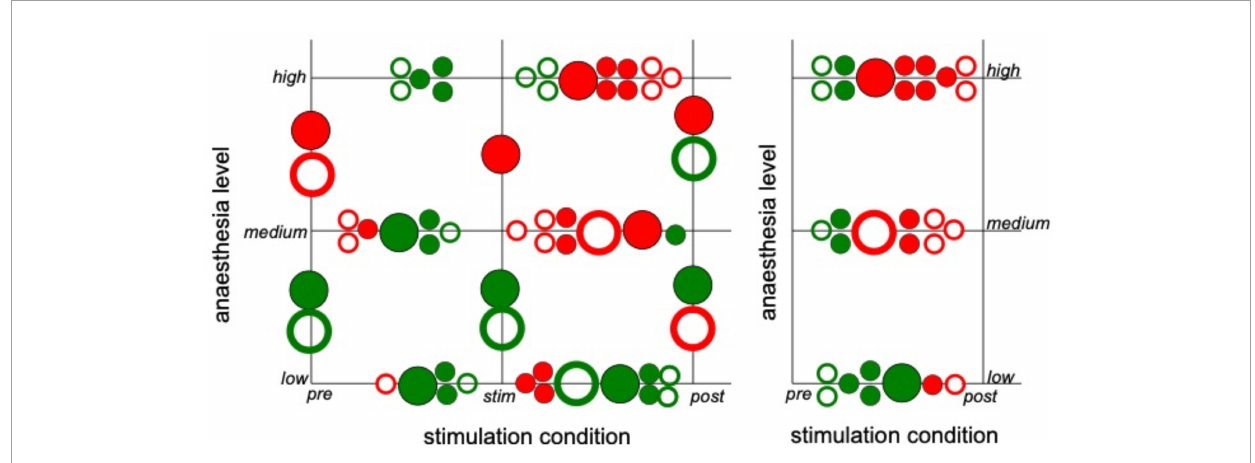
FIGURE8 Strong interaction between anesthetic level and stimulation condition. The plot summarizes statistically significant synchronization differences between stimulation condition and anesthetic level. Each large circle denotes a statistically significant results from animal averages (taken from Figures 6 , 7 ) and each small circle denotes a statistically significant single animal result (taken from Supplementary Figure 1 ). Full and empty circles represent results in slow oscillations and γ -frequency band, respectively, red and green colors indicate enhanced and diminished synchronization, respectively.